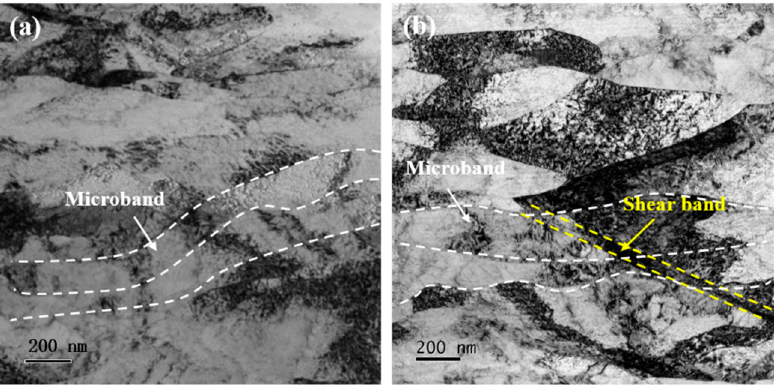
Figure 4. Substructure of rolled plate: ( a ) microbands and ( b ) shear band.